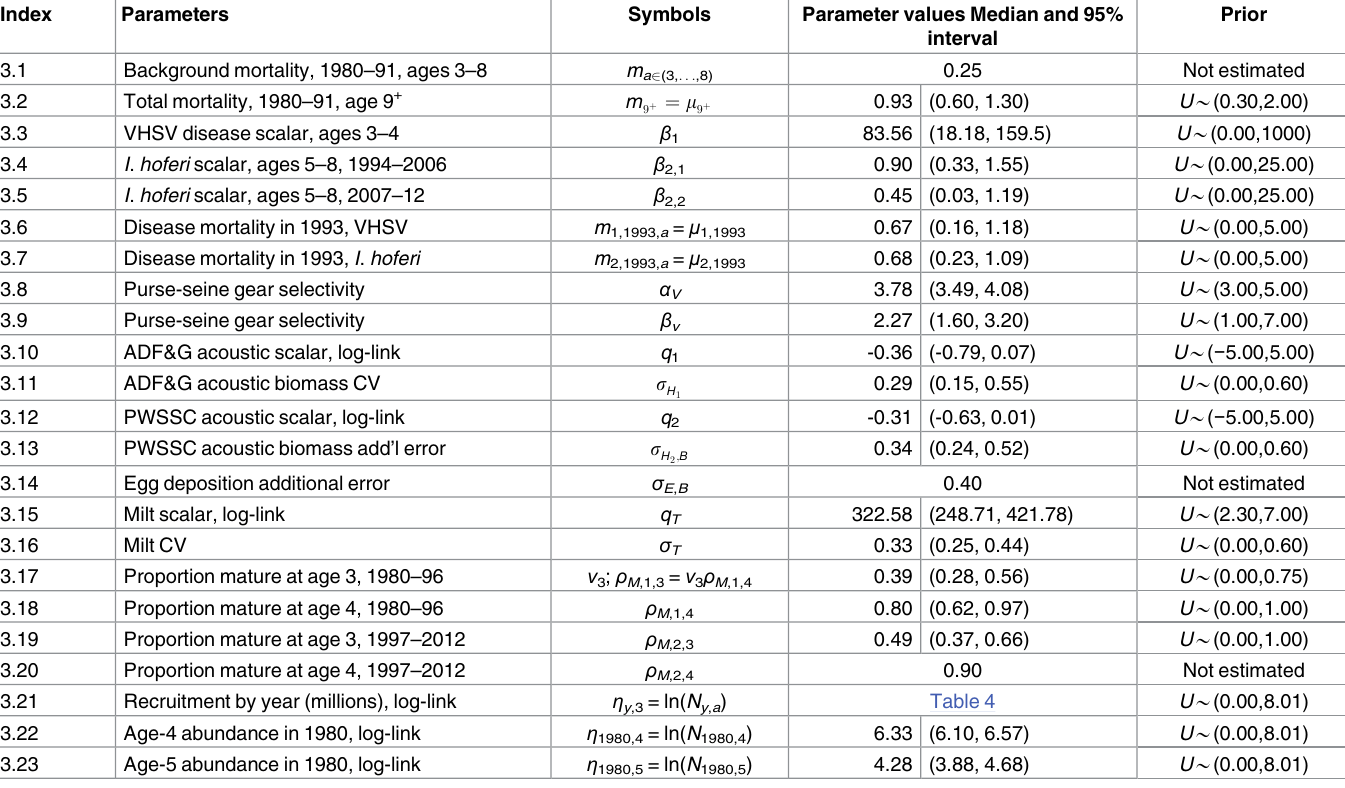
Table 3. Key model parameter estimates(medians and 95% credible intervals, CI). All mortality is modeledas instantaneous mortality